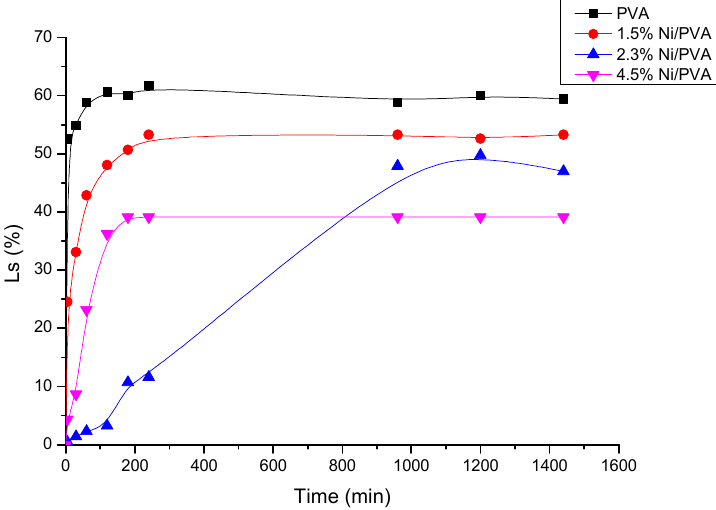
Coatings 2019 , 9 , x FOR PEER REVIEW